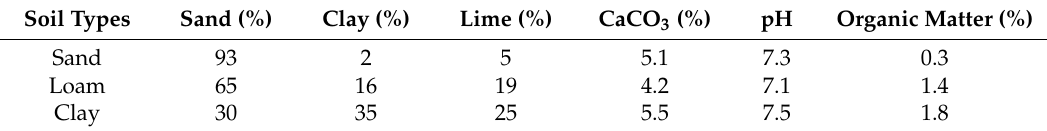
Table 1. Chemical and physical characteristics of the soils used for the